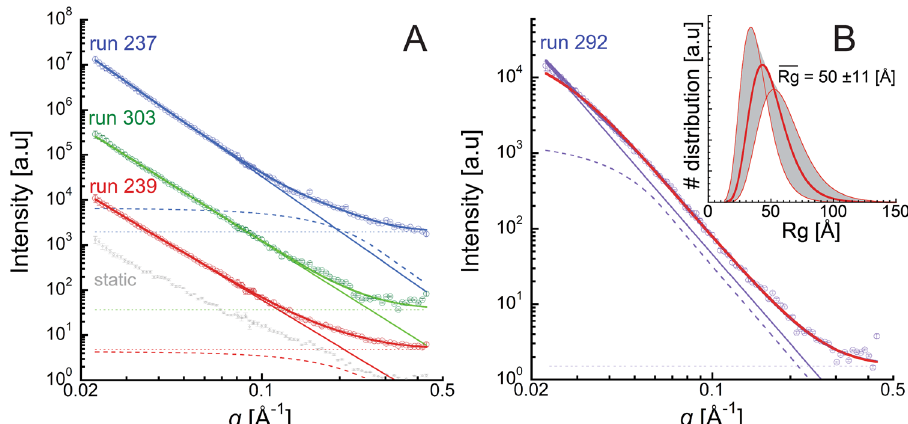
Fig. 2 SAXS pro fi les from benzene products formed within 20 ns of shock input. The SAXS pro fi les correspond to input conditions of P = 55 ± 5 GPa, T = 4940 ± 710 K (panel A ) and P = 27 ± 4 GPa, T = 2790 ± 455 K (panel B ). A SAXS data (symbols) after subtraction of the static intensity (representative static measurement shown in gray): run 239 (red), run 303 (green), and run 237 (blue). Runs 237 and 303 are offset vertically for clarity. Thick solid lines are fi ts primarily consisting of a power-law ( P 1 , thin solid lines) representing larger length scales and additional contributions from a Guinier – Porod level ( G 2 , R g2 , P 2 , dashed lines) corresponding to a ~1 nm length scale, and a constant background (dotted lines). In the case of run 303, the addition of the Guinier – Porod level did not signi fi cantly improve the fi t. B SAXS data (purple symbols) for lower pressure measurement (run 292), a 2-level model (purple lines), and intensity from Guinier-Porod levels with a log-normal R g distribution (red line). The inset shows the modeled log-normal distribution of product sizes, with a mean R g of 50 Å, and shaded ranges associated with the parameter errors.